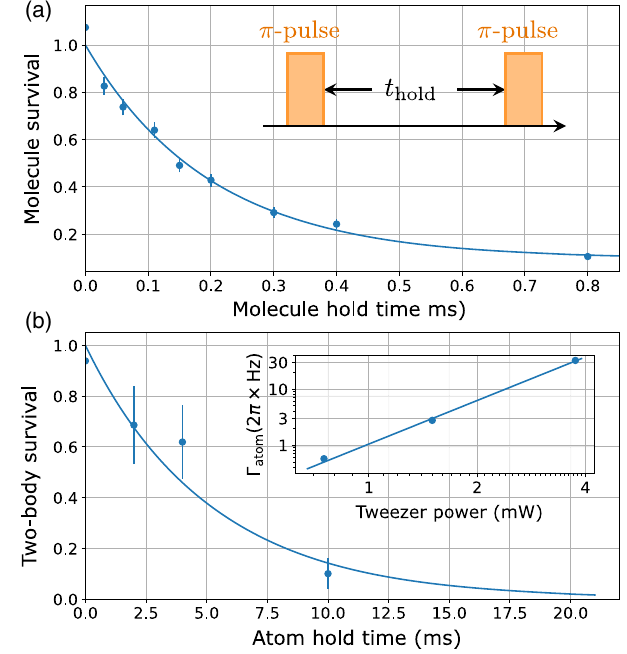
FIG. 5. Lifetime measurements with about 3.25 mW optical power. (a) Direct measurement of molecule lifetime. Molecule survival is detected by dissociating back to atoms via a second Raman transition. The lifetime is consistent with the decay of the Rabi oscillation in Fig. 3(b). Inset: pulse sequence for the lifetime measurement. (b) Two-body atom lifetime of 5(1) ms limited by off-resonance photoassociation. This is used to improve the fitting of the Raman transfer data. Inset: atomic scattering rate scales as P 2 . 58 × 2 π × 1 . 05 ð 6 Þ Hz = m W 2 . 58 on a log-log scale; tweezer this is consistent with a two-photon scattering